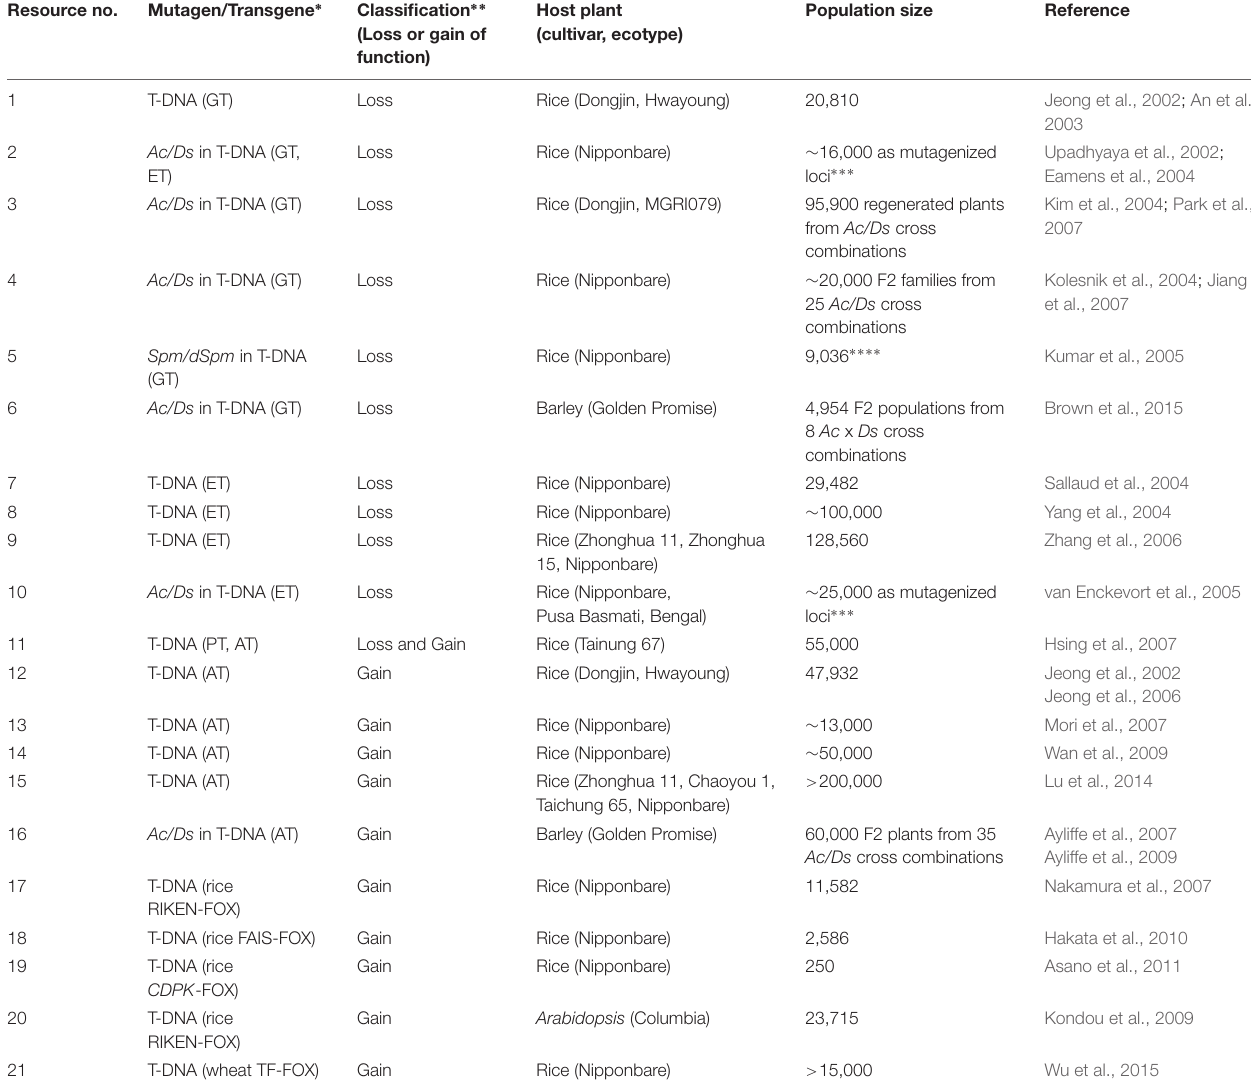
TABLE 1 | Loss- and gain-of-function transgenic resources in cereals. Resource